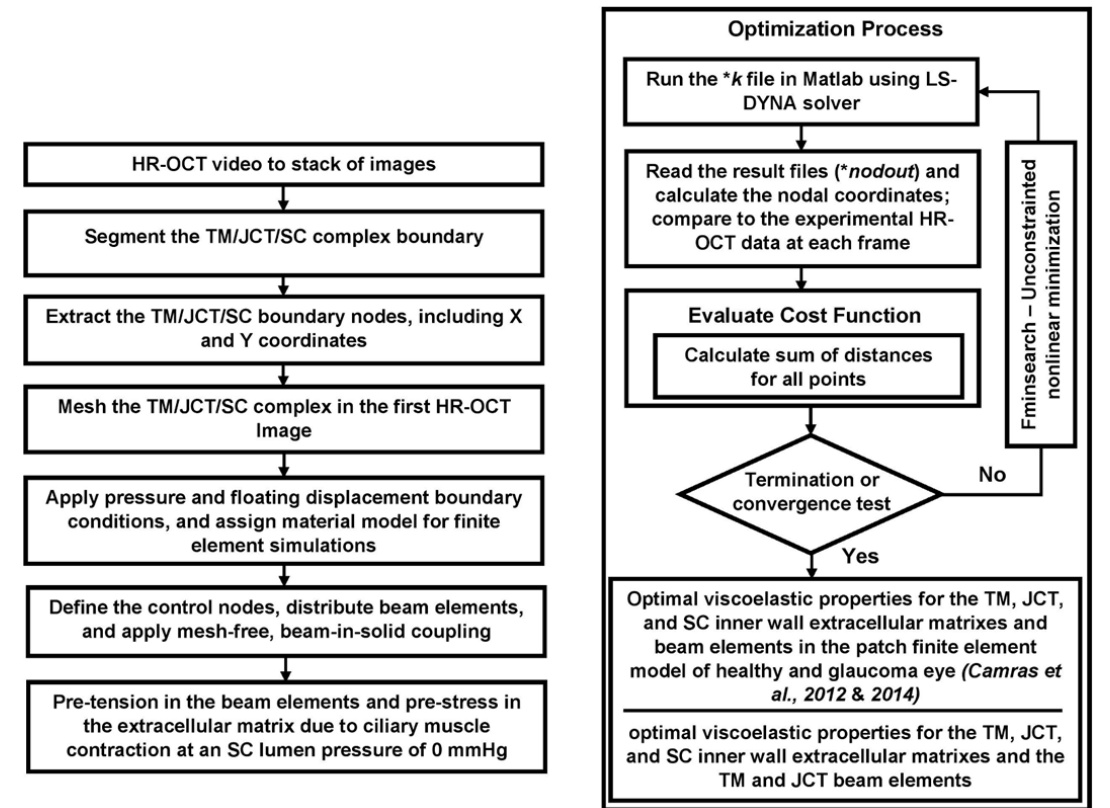
Figure 6. The flow-chart of the inverse finite element and optimization methods [91,92]. The HR-OCT with 30 B-scans/second at an appropriate distance from the cannula provided a set of dynamic images of the TM/JCT/SC complex as the pressure in the SC elevates from 0 to 30 mmHg. The TM/JCT/SC complex delineation and volume meshing are fully explained in our prior publication [69]. Briefly, HR-OCT video data were converted to a stack of images and delineated [94] under the supervision of an expert glaucoma specialist (MJ) as shown in Figure 7a. The nodal coordinates in the boundaries of the TM/JCT/SC complex were used to define the floating displacement boundary condition for the following FE